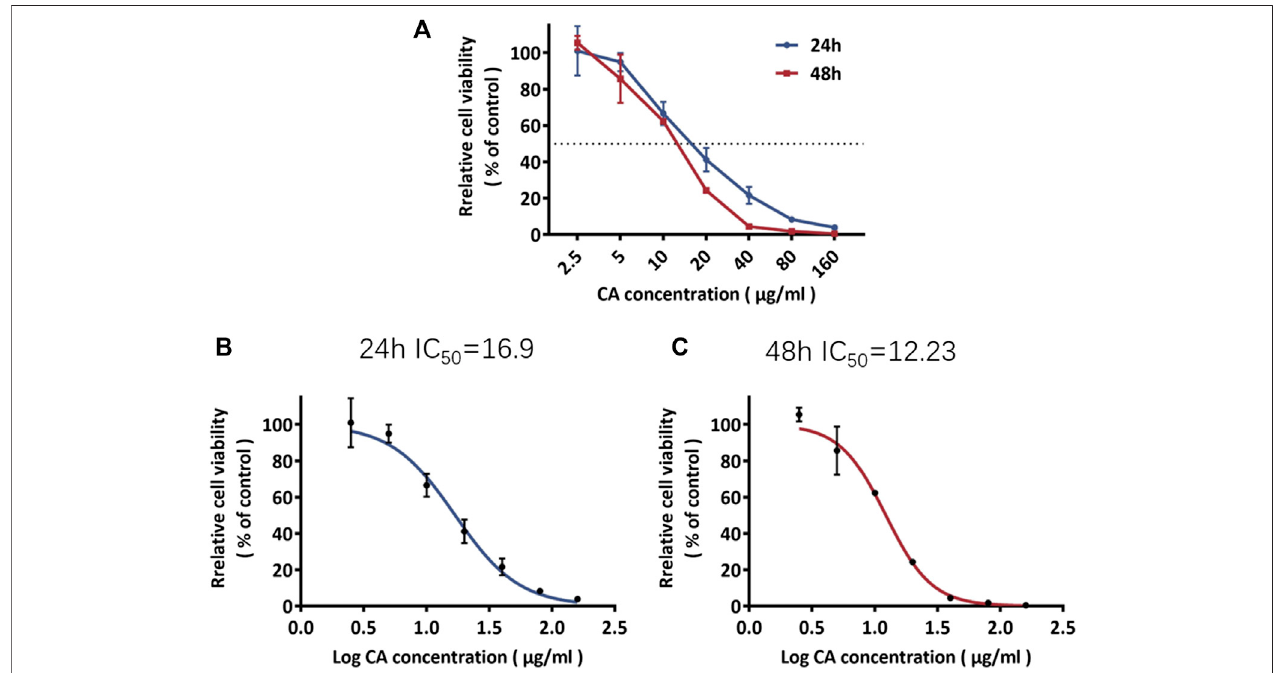
FIGURE7| Cellmorphologicaland cytoplasmicchangesin MDA-MB-231 cellsinthedifferenttreatmentgroups. (A) Cellmorphological changesofMDA-MB-231 cells in different treatment groups (original magni fi cation, × 100); (B) Hoechst 33,258 staining shows changes in the cytoplasm of MDA-MB-231 cells in different cinnamaldehyde treatment groups (original magni fi cation, × 200). CA, cinnamaldehyde.